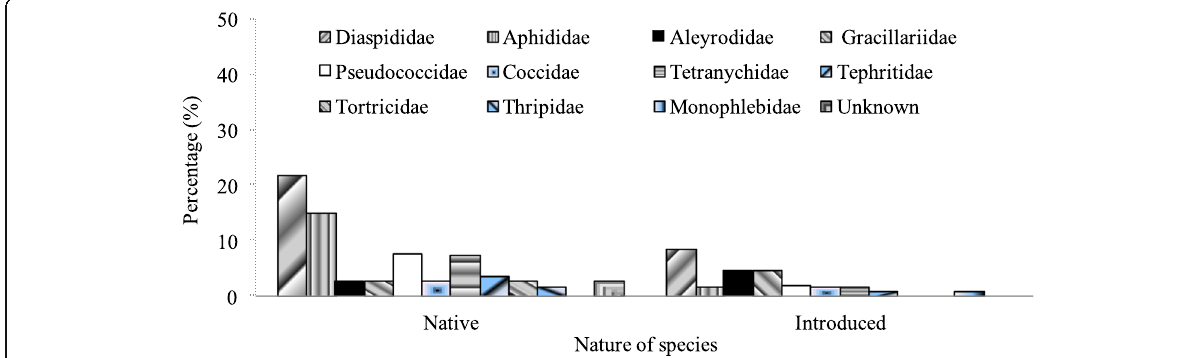
Fig. 2 Percentage of presence (%) of all beneficial species according to their targeted pests in Moroccan citrus orchards ( N =